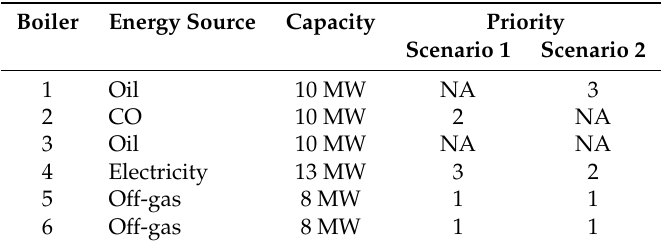
Table 1. The capacities, energy sources, and prioritization of the different boilers in the two evaluated scenarios (NA = Not